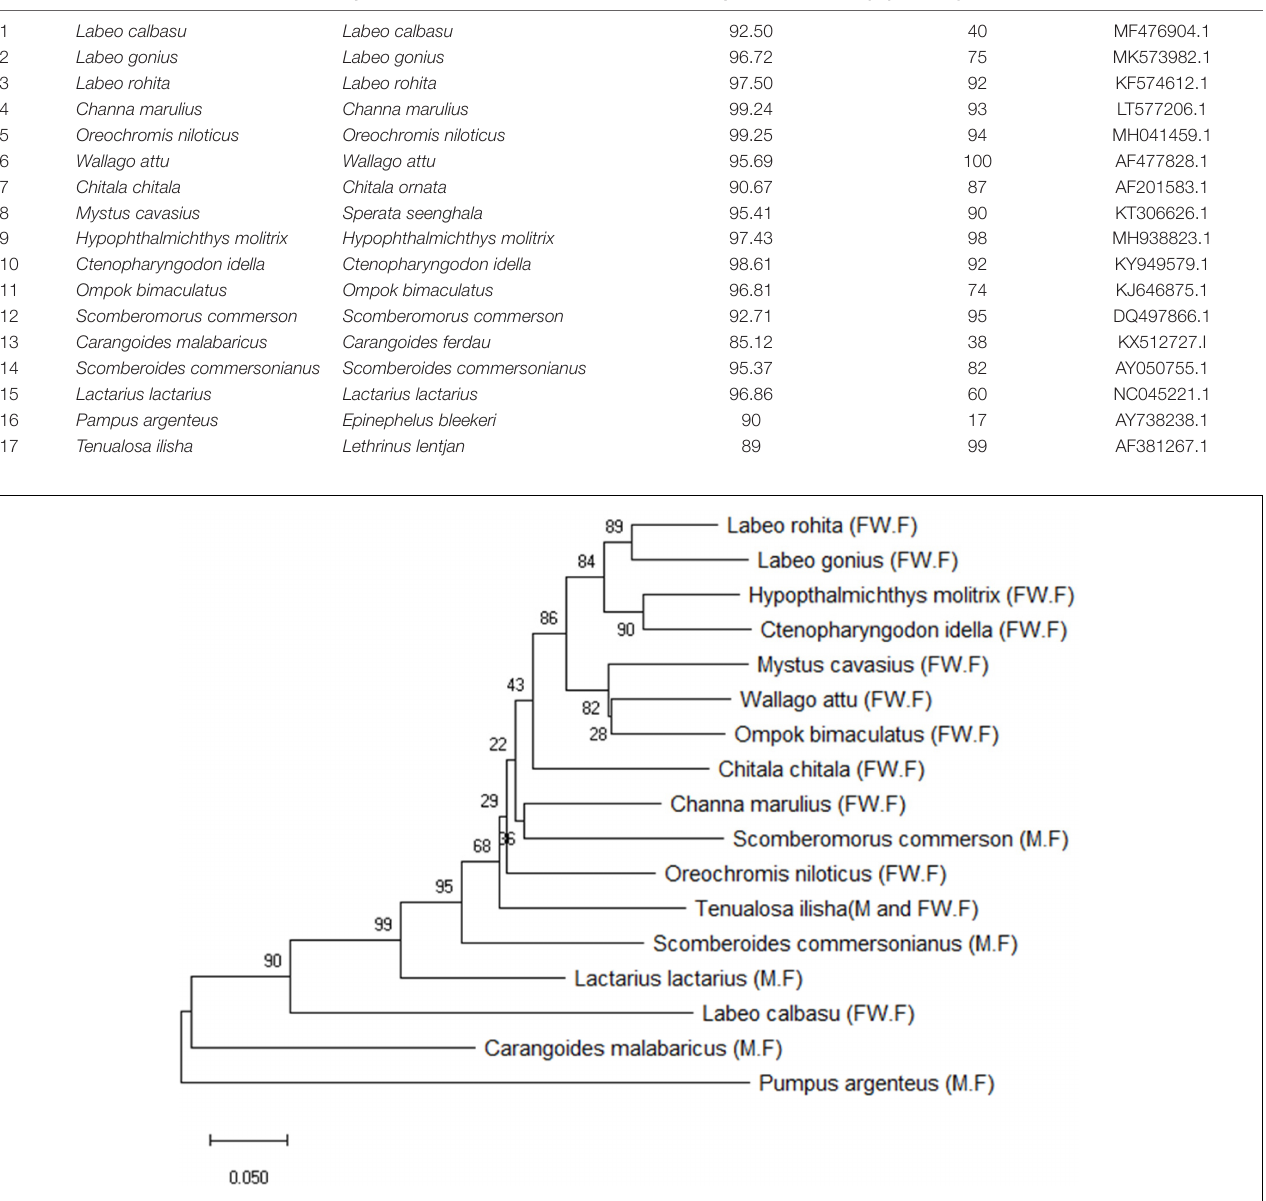
TABLE 4 | Similarity results and reference sequence (Accession no.) for freshwater and marine fish species identified by BLAST/GenBank. Sr. No. Scientific Name